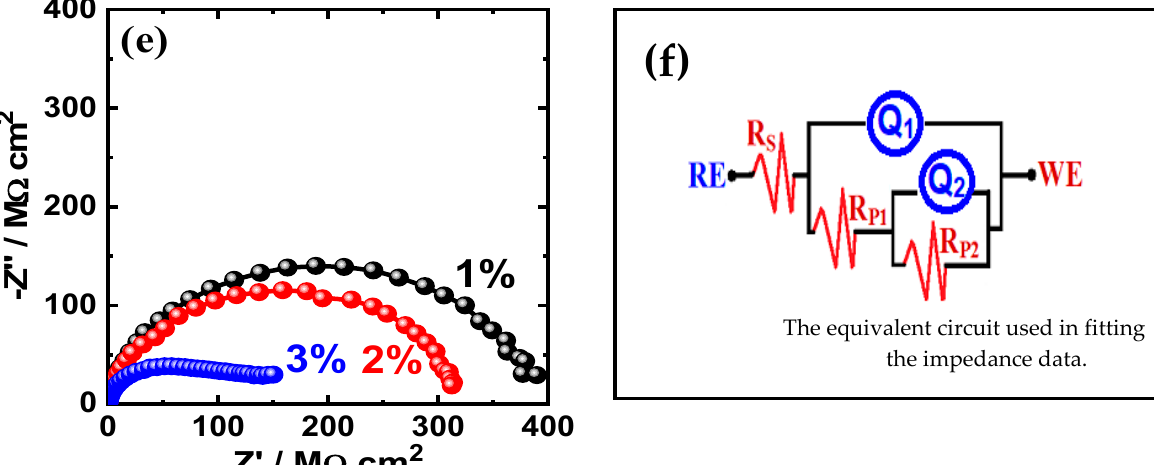
Figure 7. Nyquist plots for the coating that contains 1% Al, 2% Al and 3% Al after exposure to 3.5% NaCl solution for ( a ) 1 h, ( b ) 7 d, ( c ) 14 d, ( d ) 21 d and ( e ) 30 d, respectively; ( f ) shows the circuit model used to fit the obtained EIS data. Table 5. Parameters obtained from fitting the impedance